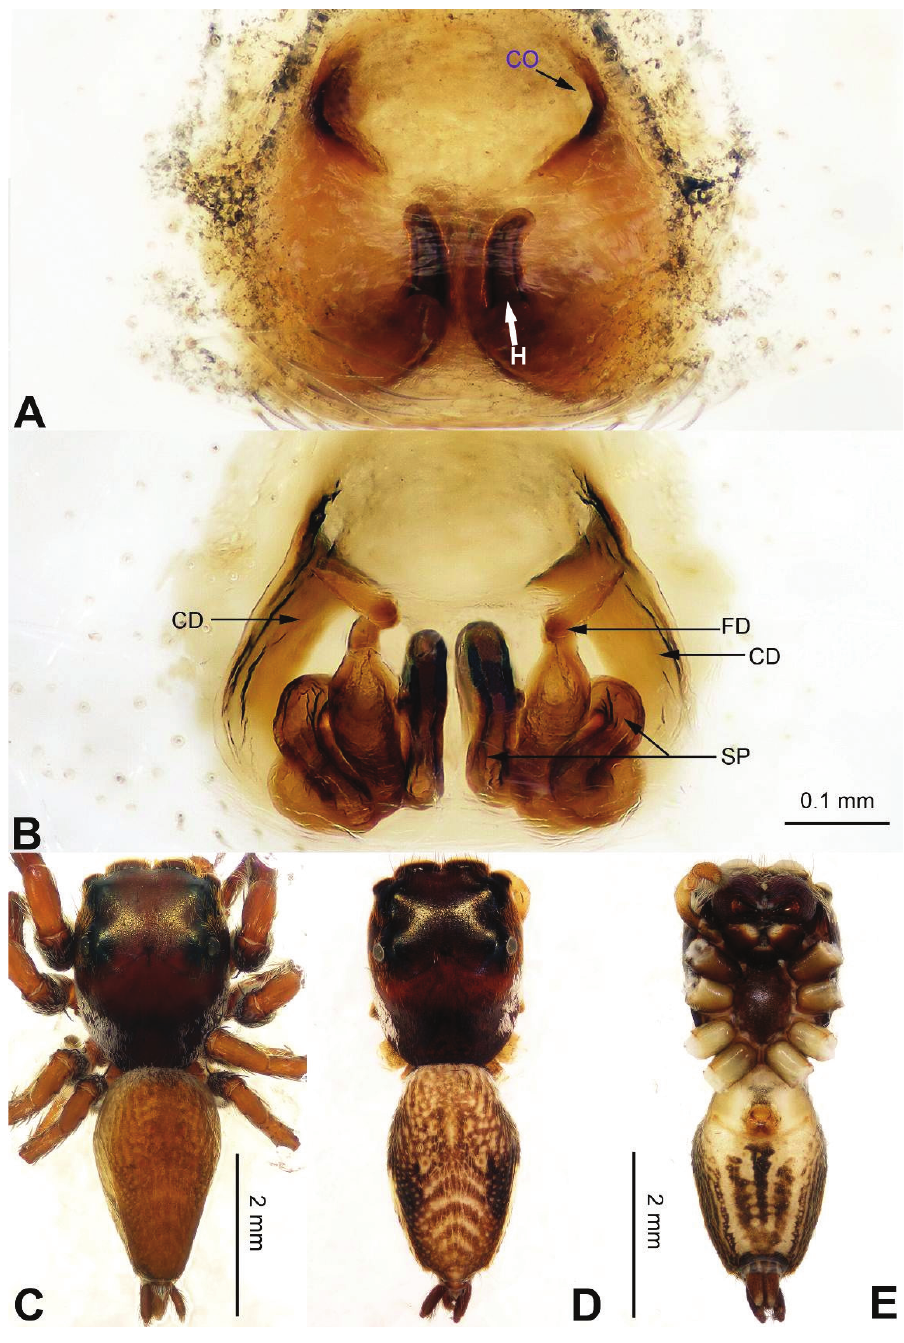
Figure 39. Ptocasius paraweyersi sp. n., female paratype and male holotype. A epigyne, ventral B vulva, dorsal C male habitus, dorsal D female habitus, dorsal E female habitus, ventral. Scale bars equal for A and B ; equal for D and E